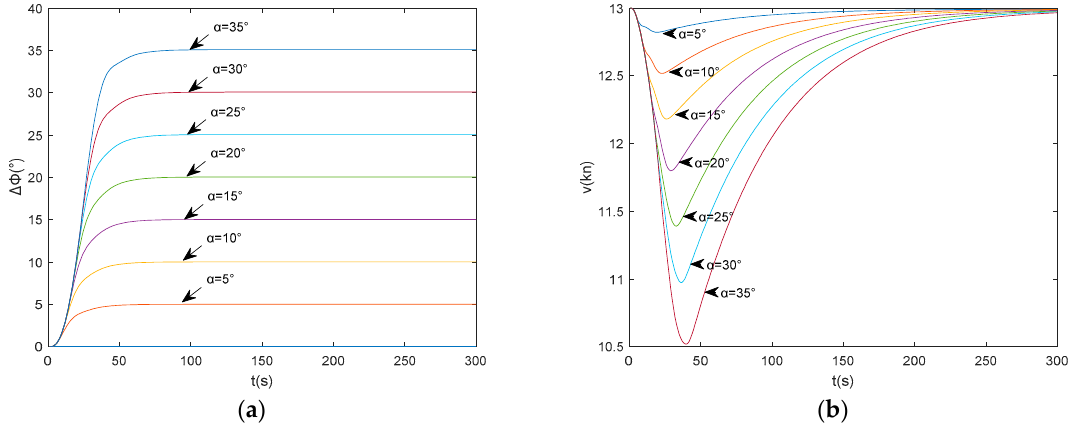
Figure 5. The dynamic properties of a ship for different desired heading changing values. ( a ) The heading angle value over manoeuvre time; ( b ) the speed value over manoeuvre time. heading angle value over manoeuvre time; ( b ) the speed value over manoeuvre